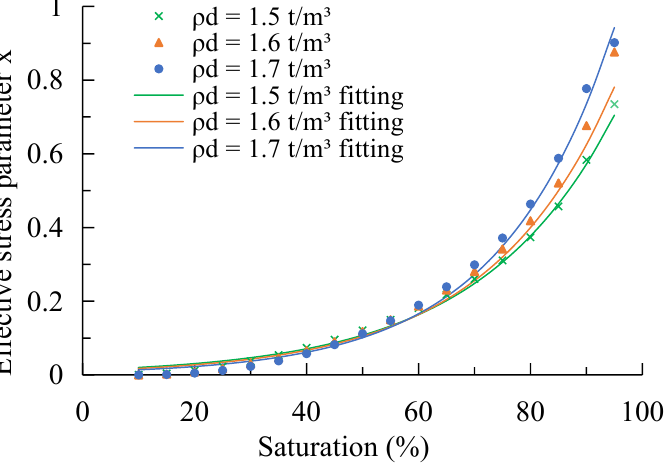
Figure 9. The effective stress parameter χ of the calculated points and fitted curve at various dry densities.